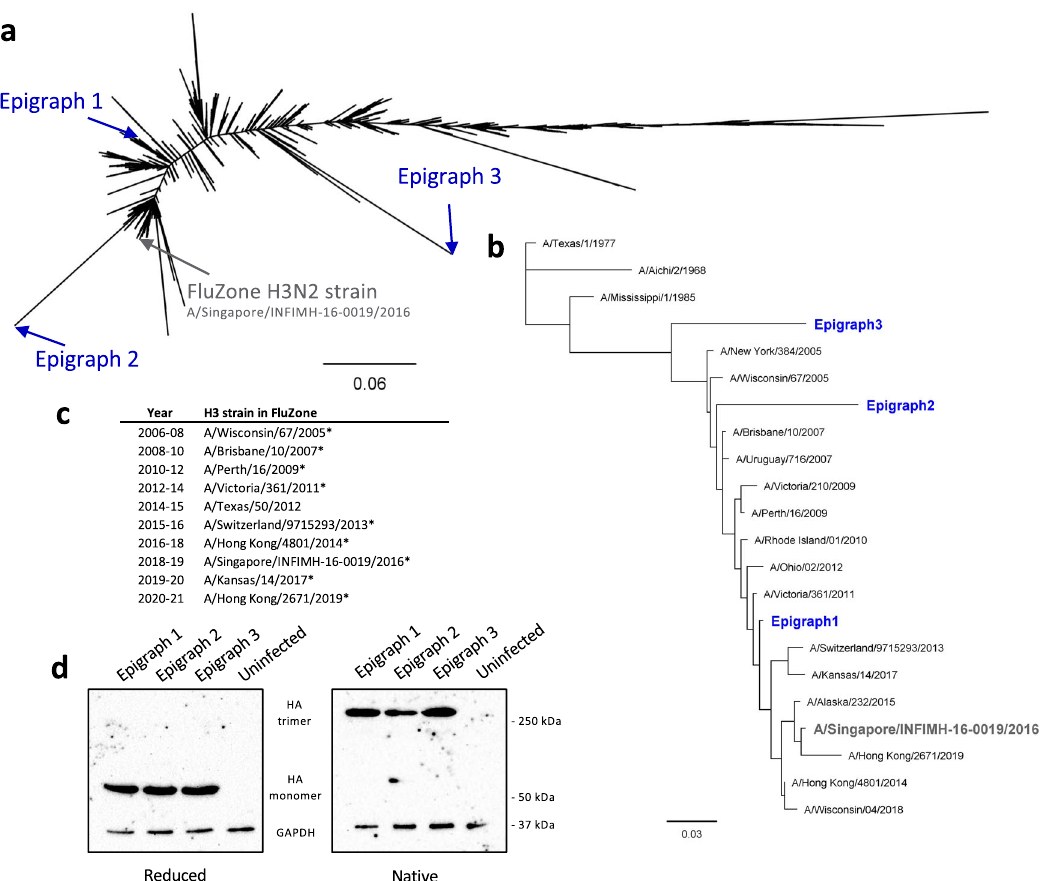
Fig. 1 Characterization of the H3 Epigraph vaccine constructs. a The Epigraph vaccine designer tool was used to create a cocktail of three H3 Epigraph immunogens (Epigraph 1, 2, and 3), which are computationally designed to maximize potential epitope coverage in the total H3 population. These Epigraph H3 immunogens were aligned back to the 5709 unique H3 HA sequences using ClustalW and a maximum likelihood phylogenetic tree was created to visualize the relationship between the vaccine immunogens and the H3 population. b A panel of 18 H3 strains was selected to examine the cross-reactivity immunity after vaccination. The selected strains span the H3 phylogenic tree and include both contemporary (2005 – 2019) and historical (1968 – 1985) strains. A maximum-likelihood tree was constructed using PhyML to visualize the relationship between the assay strains, the Epigraph vaccine immunogens (blue), and the FluZone strain (gray; A/Singapore/ INFIMH-16-0019/2016). c A table of H3 strains recommended for the FluZone vaccine each year since 2006. An asterisk indicates inclusion in this study. d The three H3 Epigraph immunogens were cloned into replication-defective Adenovirus type 5 (HAdV-5) vectors and the HA protein expression was con fi rmed by western blot. Reducing conditions were used to observe HA monomers while native conditions were to obverse HA trimers. GAPDH is used as a cellular protein loading